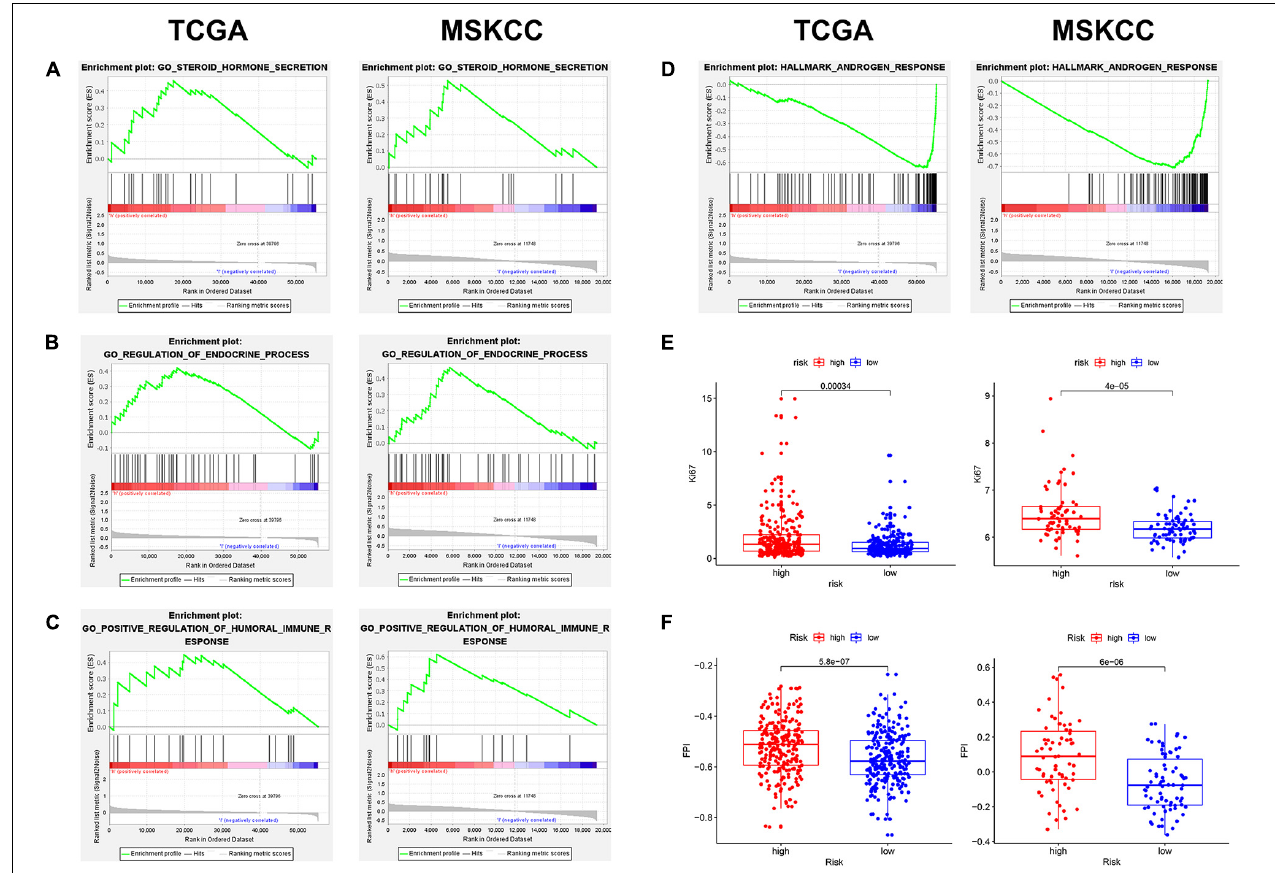
FIGURE 7 | The exploration of potential mechanism about the prognostic signature in two cohorts. (A–D) Gene set enrichment analysis (GSEA) results of the high- and low-risk groups. (E) The Ki67 expression level was higher in high-risk patients. (F) The ferroptosis potential index (FPI) level was higher in high-risk